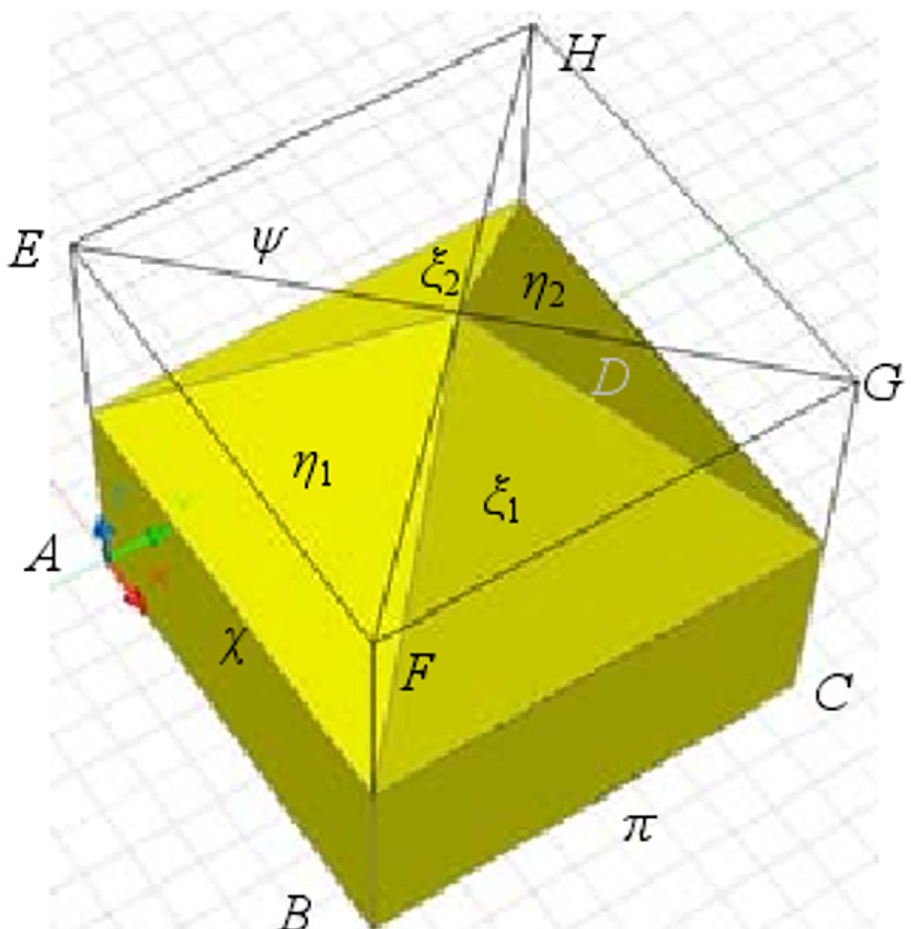
Fig 7. Geometric representation of a quadrangular pyramid.